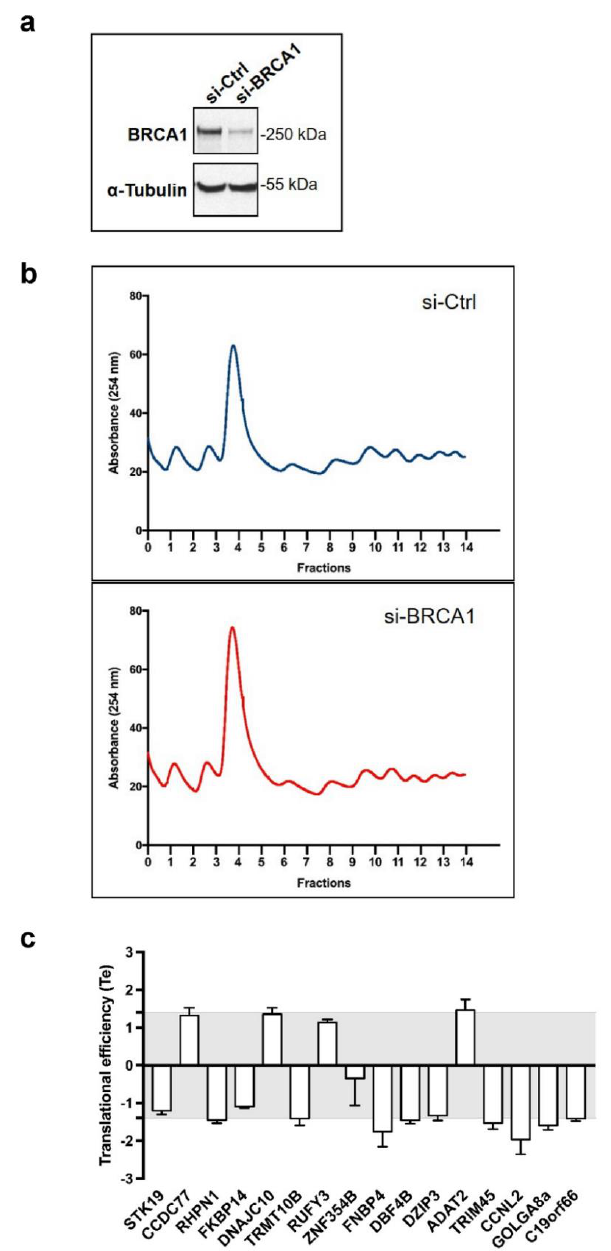
Figure 3. BRCA1 controls translation of a subset of BRCA1-associated mRNAs. ( a ) Immunoblots confirming siRNA inhibition of BRCA1 (si-BRCA1) when compared with control siRNA (si-Ctrl) in MCF-7 cells. α -Tubulin served as a loading control. ( b ) Polysomal profiles of MCF-7 cells in response to depletion of BRCA1. 40S and 60S ribosomal subunits, 80S ribosomes, and polysomes were separated by ultracentrifugation on sucrose gradients. One representative polysome profile of cells transfected with control siRNA (si-Ctrl) and with BRCA1-targeting siRNA (si-BRCA1) is shown. ( c ) Analysis of the translational efficiency (Te) of the 16 BRCA1-associated mRNAs identified in Figure 2. For BRCA1-depleted cells (si-BRCA1) and for control cells (si-Ctrl), fractions 7–14 containing polysomal material were recovered, pooled, and processed for RNA extraction. In parallel, a portion of the cytoplasmic extract was kept unprocessed to perform total RNA extraction from si-BRCA1 and from si-Ctrl cells. For each of the 16 mRNA of interest, RT-qPCR was performed on total RNA and polysomal RNA from si-BRCA1 and si-Ctrl cells. The Te was determined by calculating the following ratio: (change in abundance in polysomal mRNA in the absence and presence of BRCA1) / (change in abundance in total mRNA in absence and presence of BRCA1). Data are expressed as means ± SEM. n =